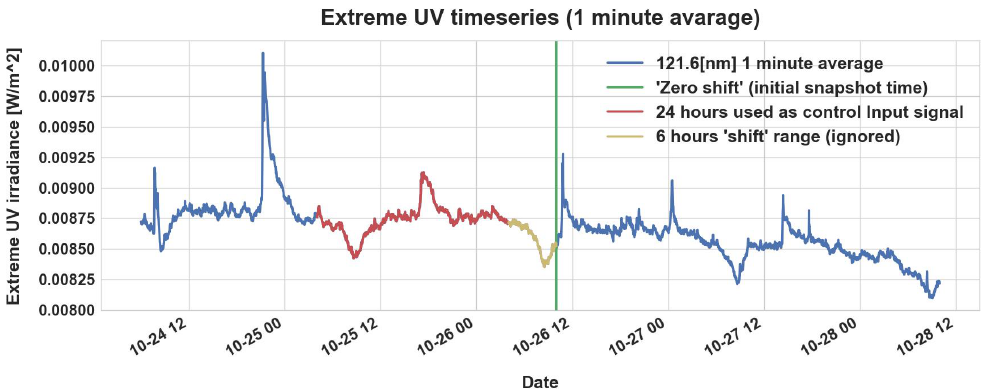
Figure 4. Example of the control input signal selection for a particular system snapshot (vTEC IGS GIM) with an initial timestamp of 2014/10/26 10:00, shift parameter of 6 h, and control input length of 24